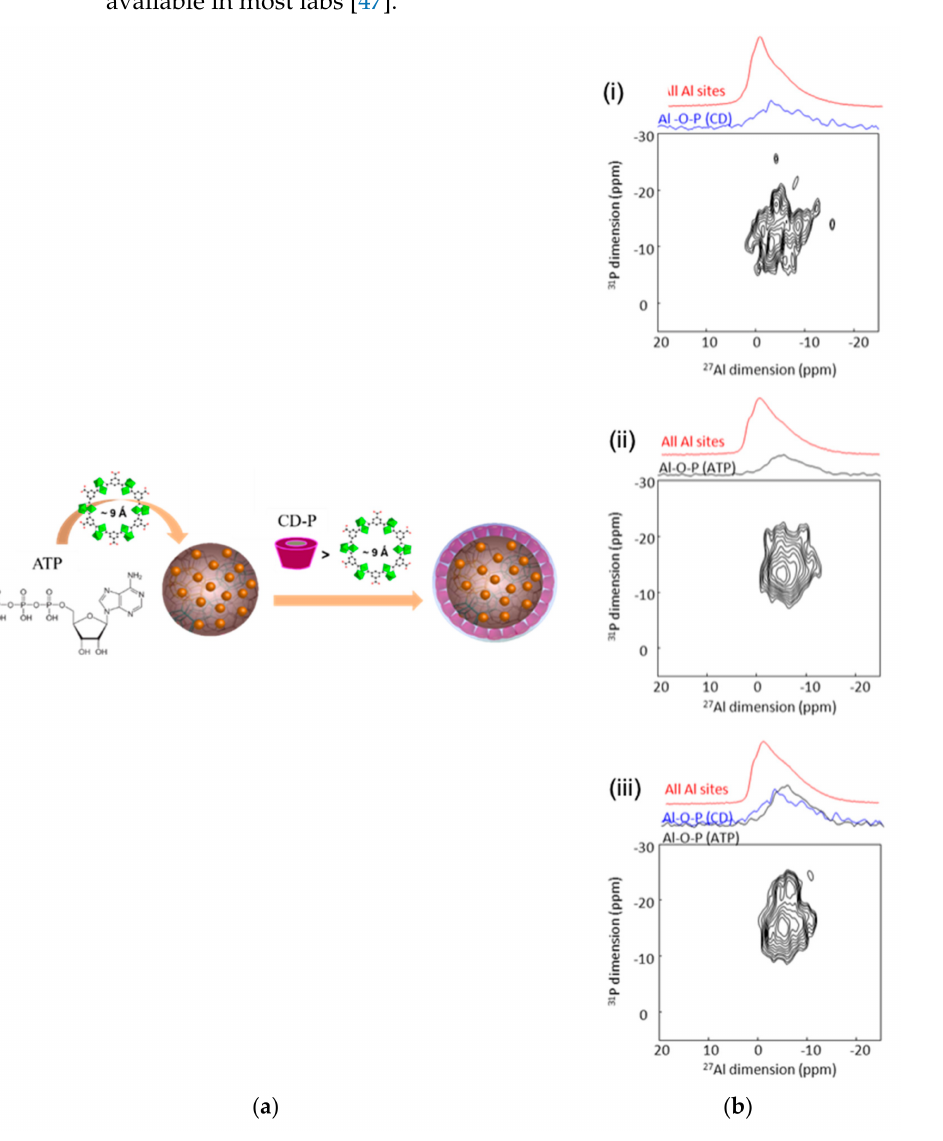
Figure 14. ( a ) Schematic representation of the highly porous MIL-100 (Al) nanoparticles loaded with ATP and then coated with CD-P; ( b ) 27 Al{ 31 P} MAS D-HMQC NMR spectra of CD-P coated ( i ), ATP loaded ( ii ), and CD-P coated ATP loaded nanoMIL100(Al) ( iii ). The top blue spectra are the full projections on the horizontal dimension for the surface sites, the black spectra are the full projection for the interphase sites, while the red spectra are the MAS NMR spectra shown for comparison